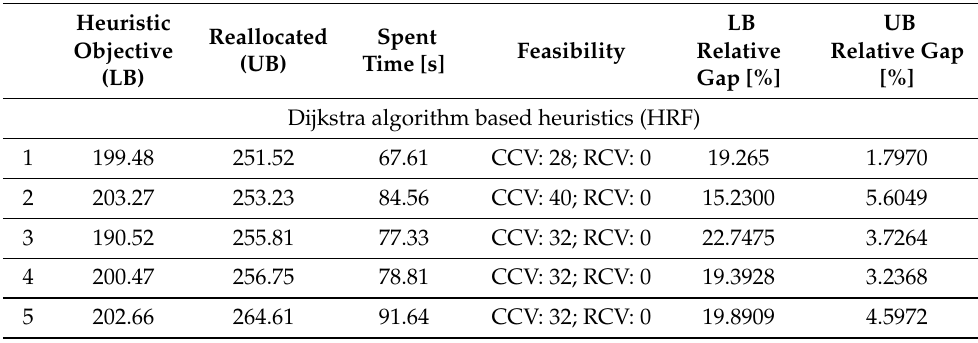
Table 10. Numerical results for large problems—Dijkstra algorithm based heuristics